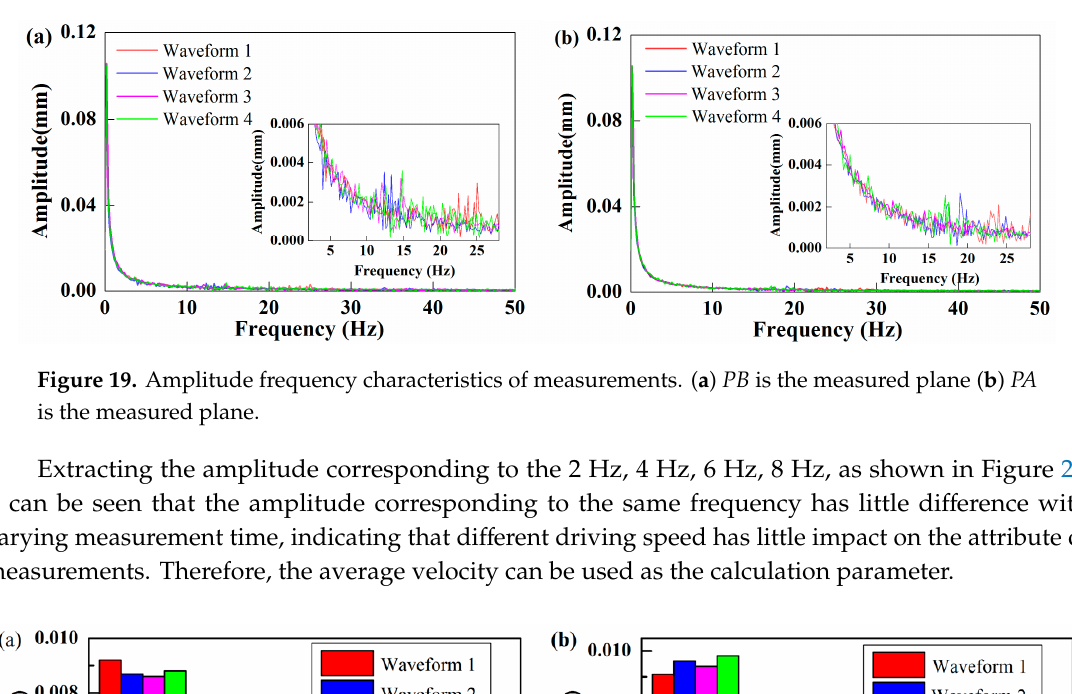
Figure 22. Combined projection curves. ( a ) PB is the measured surface. ( b ) PA is the measured surface. Figure 23 shows the average of combined projection curve of the PA and PB surfaces. Here, the data structure is the same as that of the known surface shape contours in Figure 24, and each datum corresponds to the identical detection position. As can be seen from Figure 23 the combined projection curves obtained by mutual measurement of the two surfaces are symmetrically distributed with 0 as the center, which accords with the mathematical relationship of the data corresponding to the same position in the two surfaces in Figure 13. Based on the above analysis, substituting the data in Figures 23 and 24 into Equations (10) and (11), the calculated surface shape contours are obtained, as shown in Figure 25. It can be seen from Figure 25 that the calculated surface shape contours are different from the known surface shape contours, which indicates that there exists a positional relation between two surfaces PA and PB .